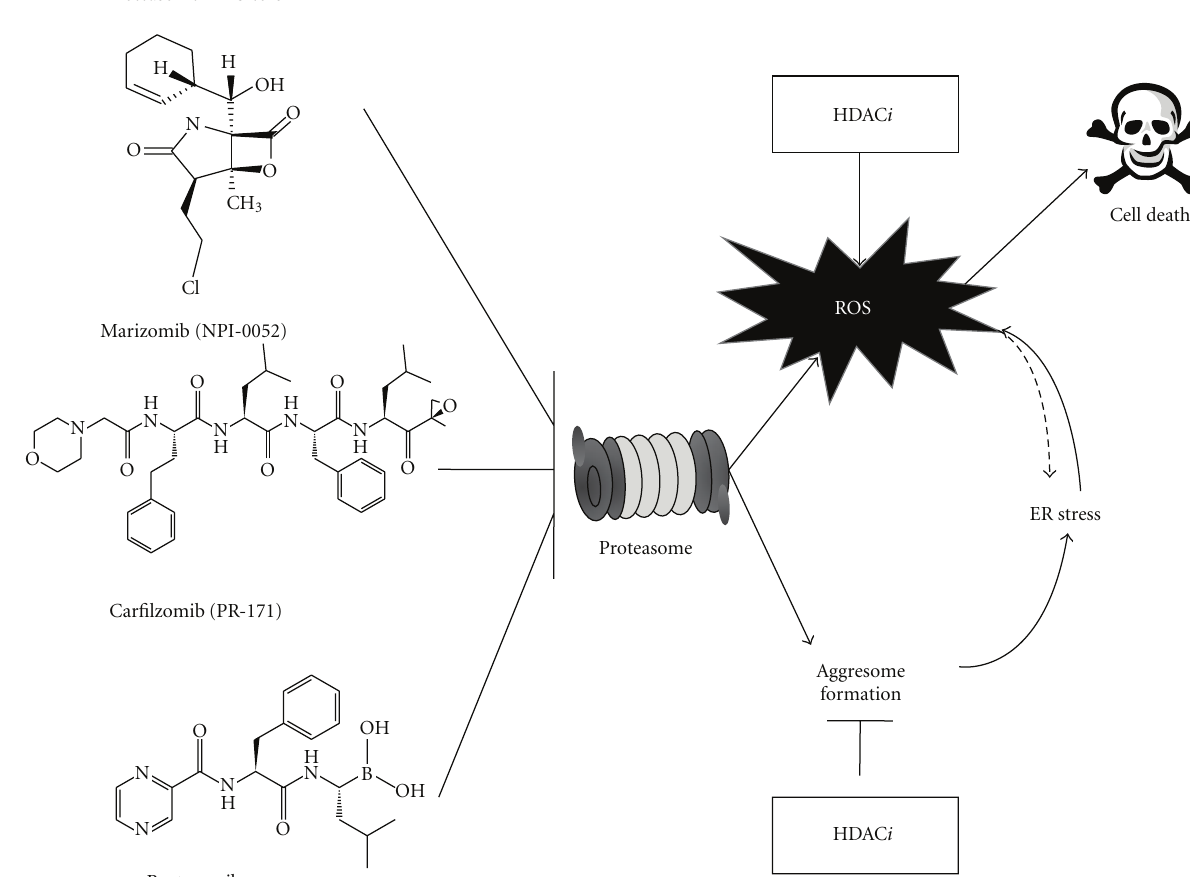
Figure 3: Combination of HDACi with proteasome inhibitors induces cellular stress. Synergistic apoptosis is observed between HDACi and three structurally di ff erent proteasome inhibitors—marizomib, carfilzomib, and bortezomib. The cell death observed with this therapeutic strategy is generally oxidant dependent. Individually both proteasome inhibitors and HDACi generate ROS, either via mitochondrial injury or by disregulating antioxidant systems as described in the text. When paired, these two compounds dramatically increase oxidative stress, which leads to apoptosis. High levels of ROS can also cause damage to proteins which can contribute to ER stress. Inhibiting the proteasome also results in aggregates of conjugated ubiquitin proteins that were originally to be degraded by the proteolytic complex. HDAC 6 mediates aggresome formation as a cytoprotective measure in the cell. Addition of HDACi disrupts aggresomes, leading to ER stress, which can stimulate oxidative stress or directly induce